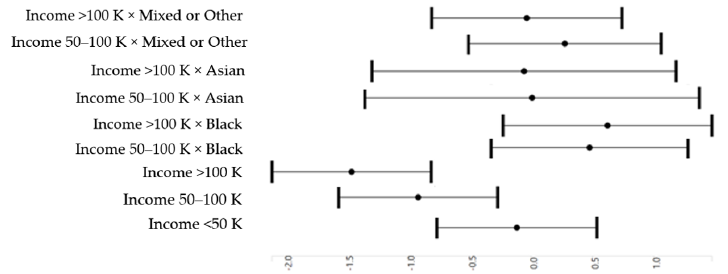
Figure 2. The association between family income and children’s screen time by race.